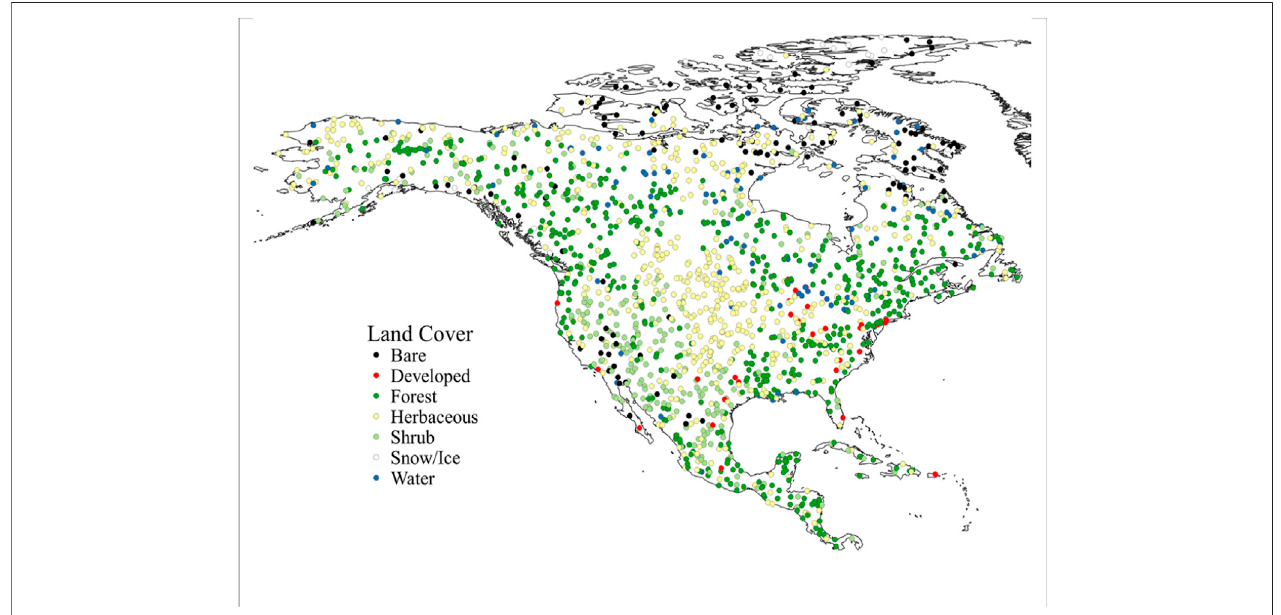
FIGURE7| Map showinglocationsofreferencesitesselectedbysimplerandom sampling. Thesesitesareused toassess theaccuracyoftheGLanCE landcover map for 2010 ( Table 4 ), and to compare the 2019 GLanCE land cover map against the ESA WorldCover 2020 data set ( Table 5 ).